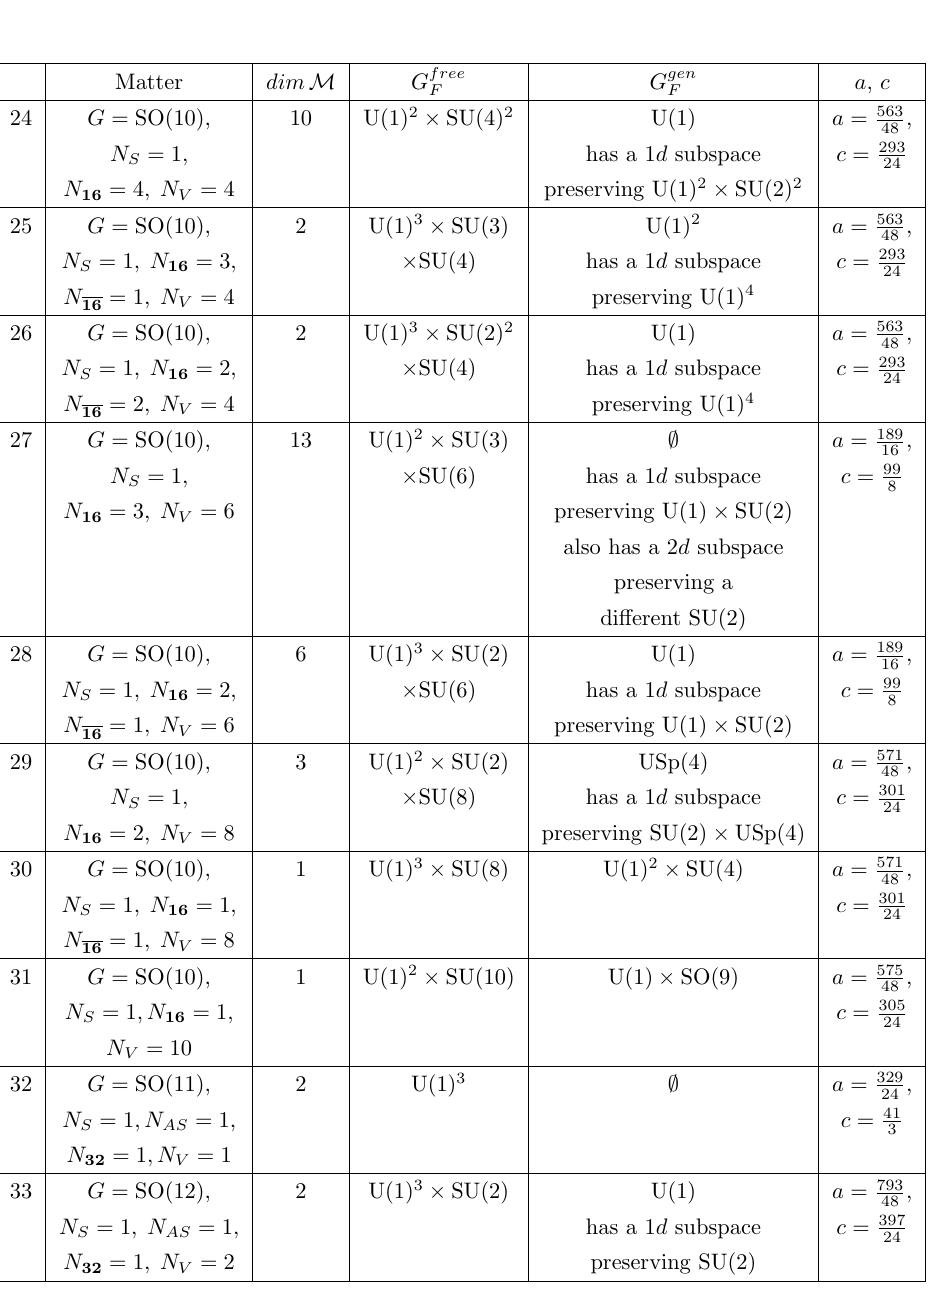
Table 22 . Cases involving an SO(10), SO(11) or SO(12) gauge group with ‘exotic’ matter. (cid:15) In case 26 the U(1) 4 consists of the U(1) acting on the spinor and vector only, which is never broken, and the U(1) 3 factor, which is some combination of the Cartans of the SU(4), the two SU(2) groups, and the other